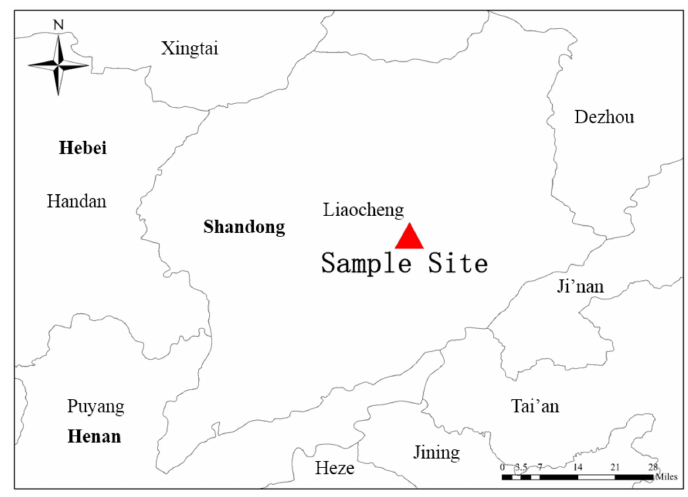
Figure 1. Sampling site